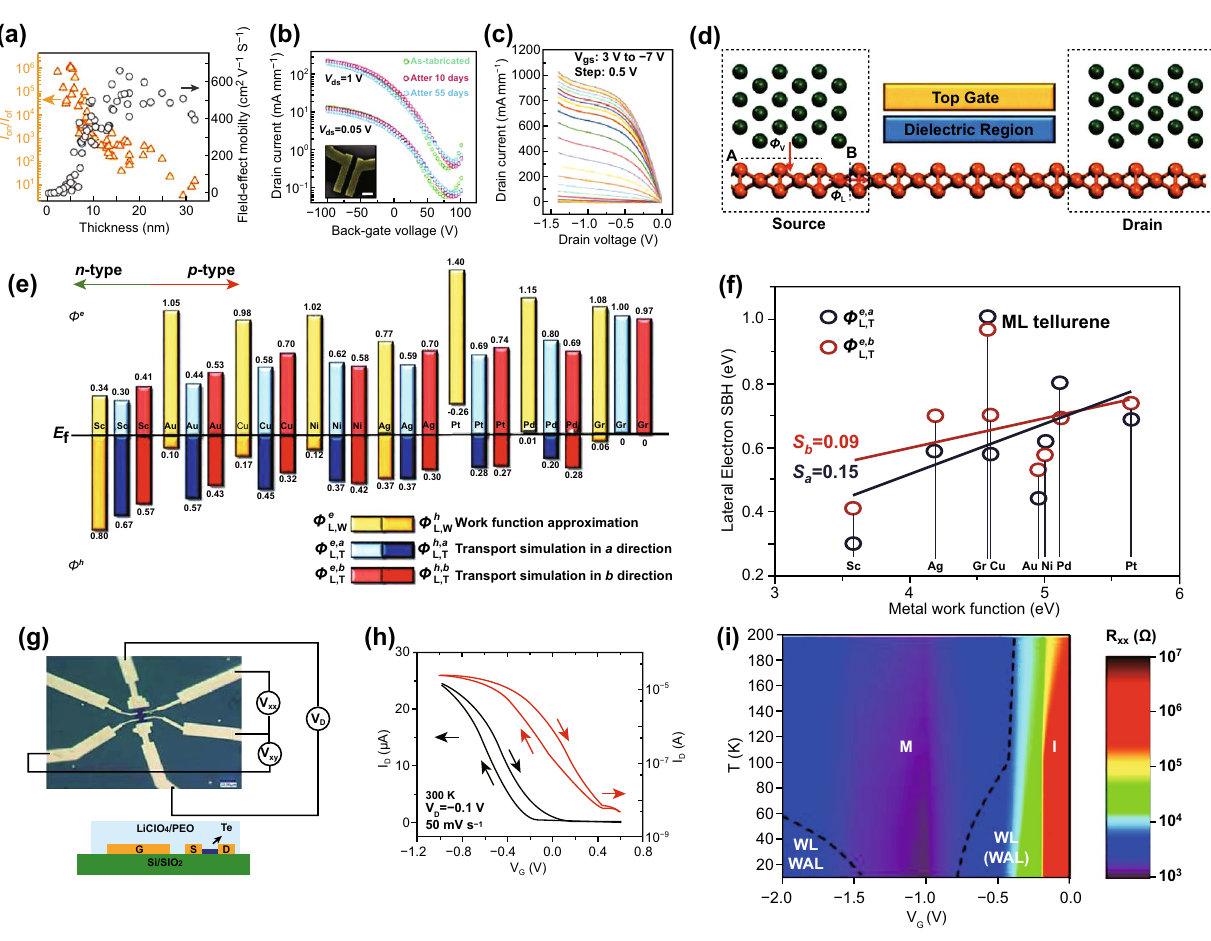
Fig. 12 a Measured on/off ratio and field‑effect mobility of transistors based on 2D Te as a function of thickness. b Transfer curves of the 15‑nm‑thick Te‑based transistor. Inset: SEM image of the 2D Te‑based transistor. c Output curves of the 2D Te‑based transistor with a thick‑ ness of 11.1 nm and a channel length of 300 nm. Adapted with permission from [25]. Copyright 2018, Nature Publishing Group. d Schematic of monolayer Te‑based FETs. e Lateral Schottky barrier height (SBH) comparison of the monolayer Te‑based FET. f Lateral electron SBH com‑ parison versus the metal work function in the A and B direction (from part d ) for the monolayer Te‑based FETs. Adapted with permission from [174]. Copyright 2018, The Royal Society of Chemistry. g Optical microscopy image and schematic side‑view of a 2D Te‑based EGT. h Transfer curves of the device at 300 K. i Gate‑voltage‑dependent electronic phase diagram of the Te‑based EGT. Adapted with permission from [175]. Copyright 2019, American Chemical